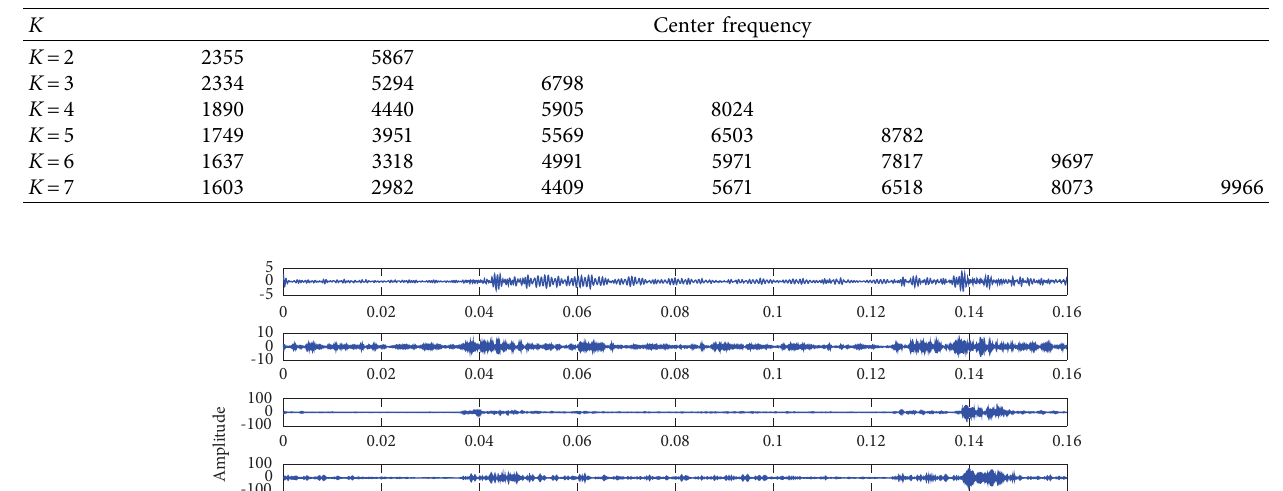
Figure 18: Time domain waveform of a vibration signal. (a) Early stage. (b) Late stage. Table 7: Center frequencies under diferent K values.